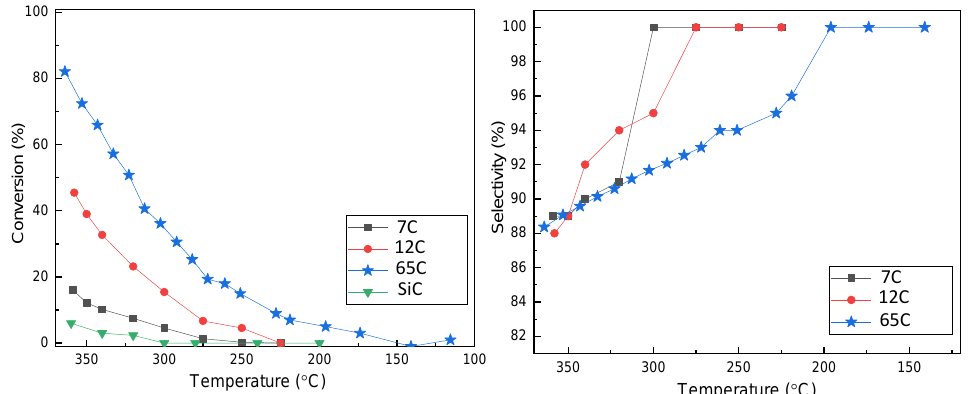
Figure 6. Conversion and selectivity as a function of temperature for Pd-C thin films with different compositions.